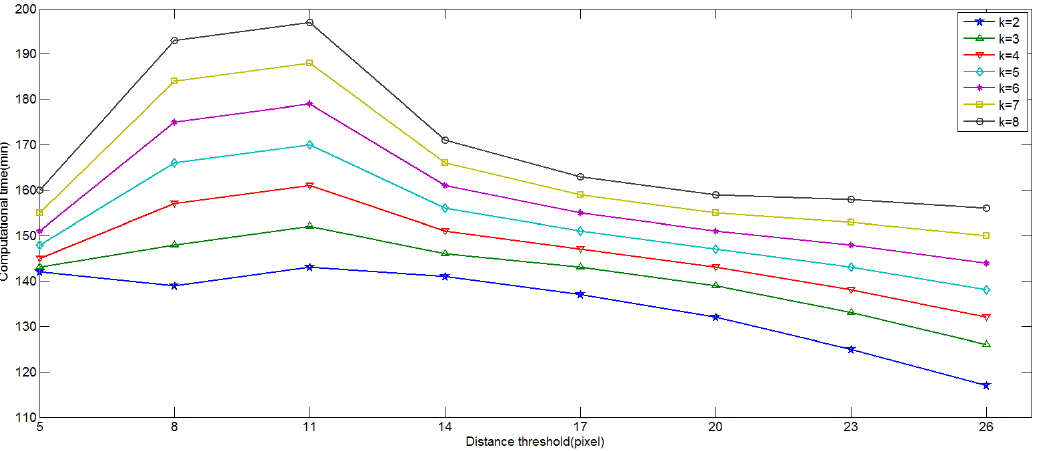
Figure 19. Computational time for generating BOW features with different distance thresholds and the number of clusters over UC_MERCED dataset.